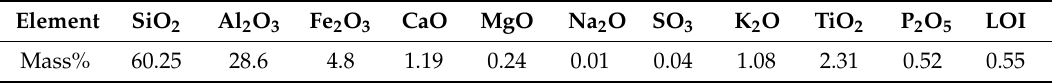
Table 4. Chemical composition of used fly ash (FA) [31].